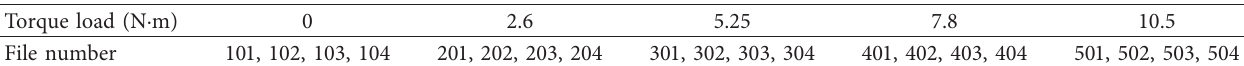
Figure 3: Test bench and seven different types of faults. Table 1: Five operating